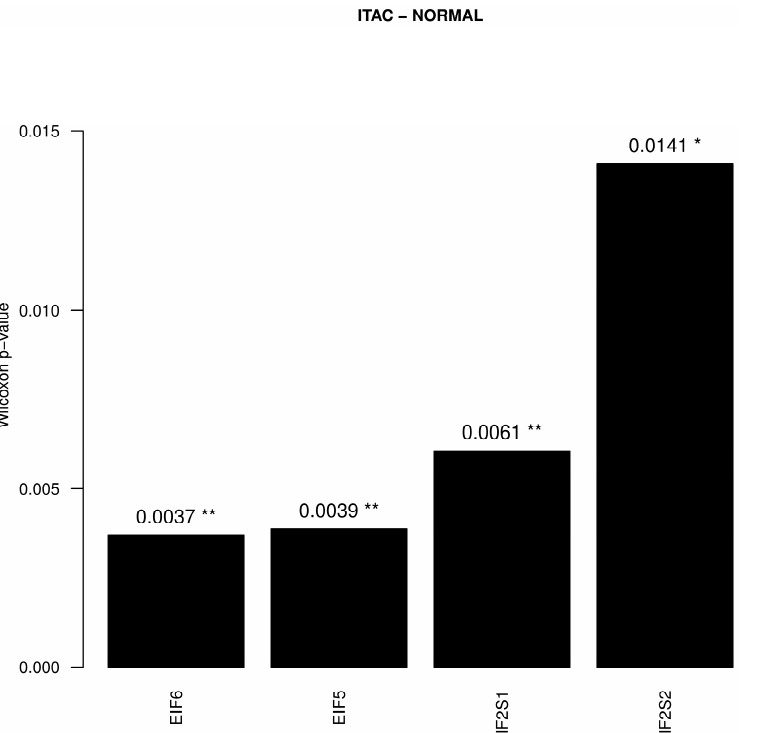
Figure 1. Significant Wilcoxon p -values of the translation factors ( p < 0.05). Each factor was compared against the same factor between the groups ITAC and NNT in the dataset GSE17433. Black bars indicate that the arithmetic mean of the first group (ITAC) was higher than the arithmetic mean of the second group (NNT) and white bars indicate the opposite. ** indicate a p -value < 0.01, * indicates a p -value < 0.05.